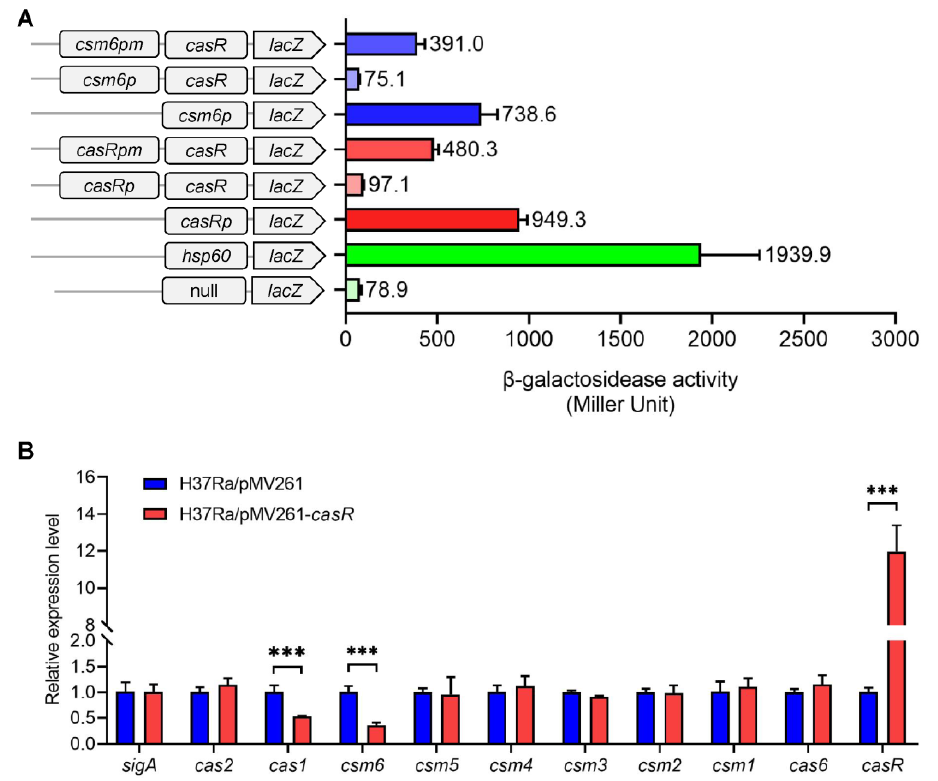
Figure 6. CasR negatively regulates the expression of csm6 . ( A ) β -galactosidase activity assay. Schematic diagram of plasmids containing promoter- lacZ and promoter-CasR ORF- lacZ . All the plasmids were transformed into the M. smegmatis . The activity of β -galactosidase is expressed as Miller units. Data are expressed as the mean ± standard deviations of three independent replicates. ( B ) Relative expression levels of CRISPR-associated genes via qRT-PCR in the casR -overexpressing strain and pMV261 control strain. The relative expression levels of the genes were normalized using the sigA gene as internal control. Relative expression levels of genes were calculated using the 2 −ΔΔCt method. The differences in the relative expression levels between groups were analyzed via unpaired two- tailed Student’s t -test, using GraphPad Prism 8. Asterisks represent significant differences (***, p ＜ 0.001) between two groups.